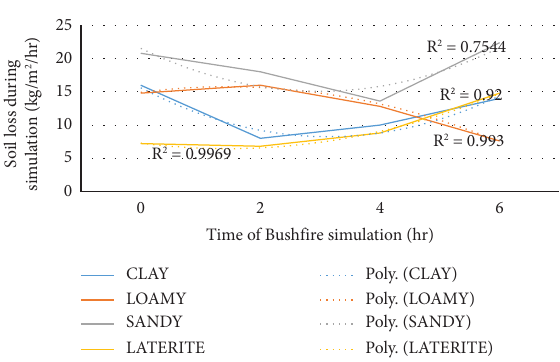
Figure 3: Soil loss vs. heating time.